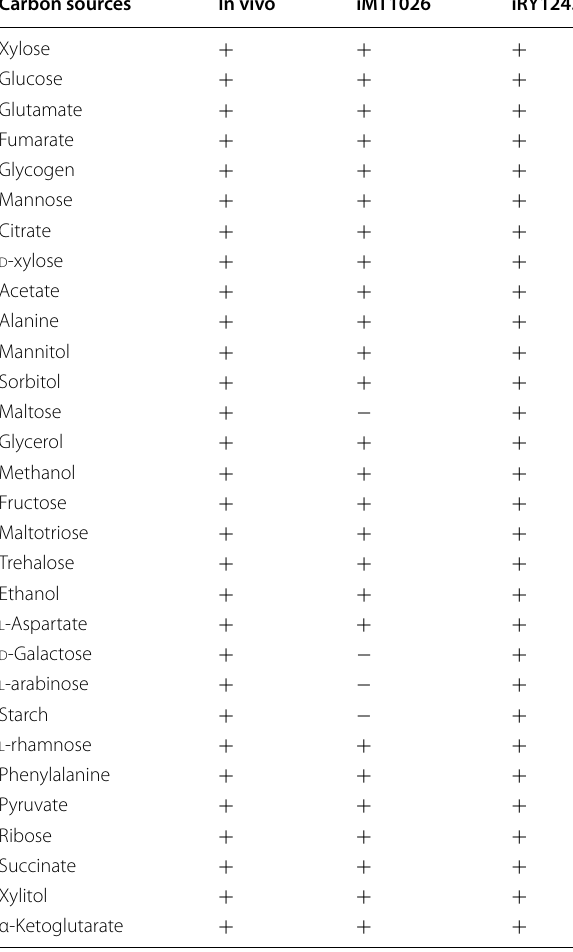
Table 3 Evaluation of growth capabilities of P. pastoris on different carbon sources ( growth) Carbon sources In vivo iMT1026